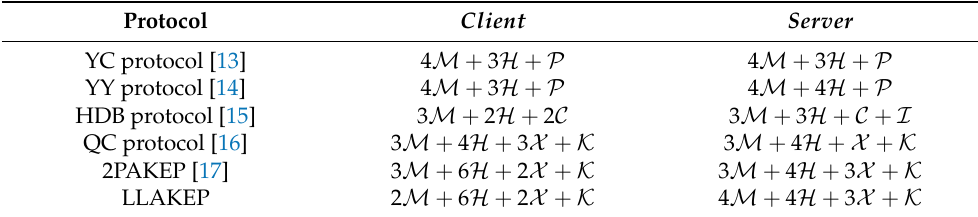
Table 6. Comparison of computation